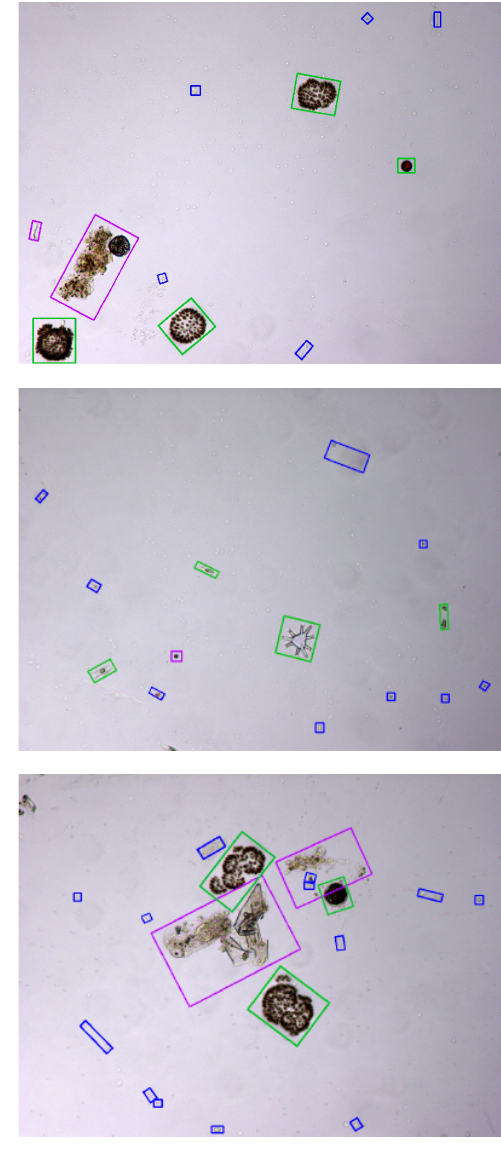
Figure 8. Final results of the work—true positives in green, true negatives in blue, false positives in violet and false negatives in